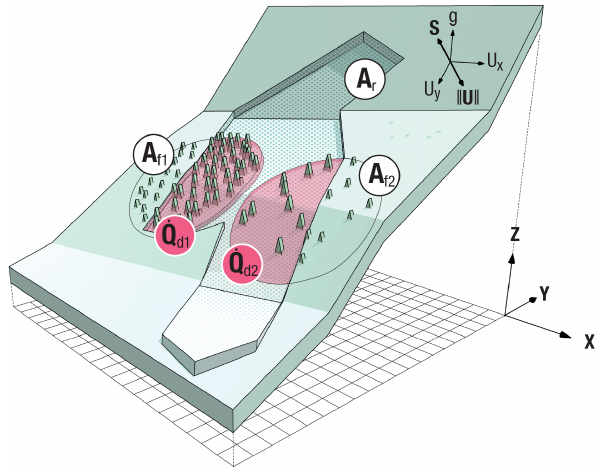
Figure 1. Schematic illustration of avalanche modeling in forested terrain. The release area ( A r ) as well as forested areas ( A f ) have to be defined by the avalanche expert and assigned an appropriate K value dependent on specific forest characteristics which deter- mine the detrainment rate ( ˙ Q d ). Avalanche flow in general is mod- eled by the velocities in x and y direction ( U x and U y ) and by the friction S acting in the opposite direction than | U | , and the gravita- tional acceleration g